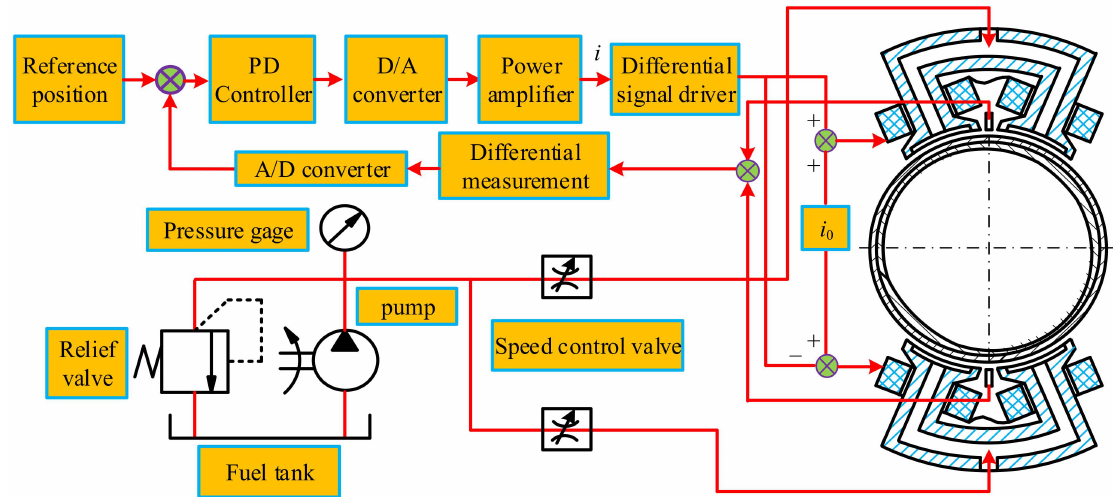
Figure 3. Single-DOF supporting system for MLDSB.